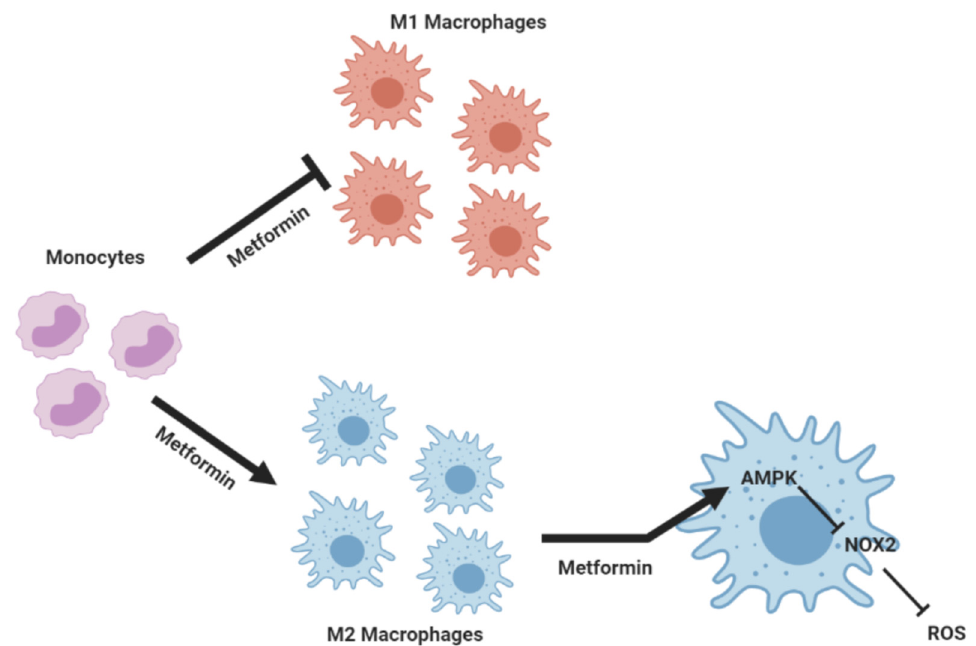
Figure 8. Schematic representation of metformin’s action on macrophage polarization, showing its anti-inflammatory and antioxidant effects on macrophages. Metformin inhibits the polarization of M1 macrophages while favoring M2 macrophages. In addition to this effect, metformin dampens ROS production by these cells. Metformin may exert its anti-inflammatory and antioxidant effects through the reduction in NOX2-induced ROS production in an AMPK-dependent manner.